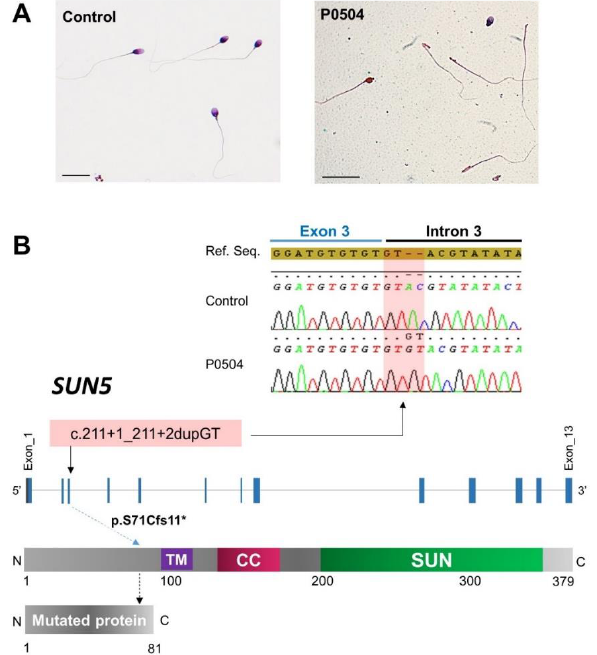
Figure 1. Sperm morphology and a description of the identified SUN5 variant. ( A ) Light microscopy analysis of spermatozoa from a fertile control individual and a subject carrying the identified SUN5 variant (P0504). Mutated subjects have numerous isolated flagella and few isolated abnormal heads. Scale bars = 20 µ m. ( B ) The identified homozygous variant, as shown in the electropherograms, is located within a GT repetitive sequence located at the junction of exon 3 and the downstream intron (intron 3). We observe that the end of the exon 3 sequence contains three repetitive GT doublets, followed by the consensus donor splice-site sequence (GT) in intron 3. The identified variant causes the extension of this repetitive sequence and is predicted to impact both splicing and translation, leading to the production of a short and non-functional SUN5 protein. The purple box represents a transmembrane domain (106–122 aa). The pink box represents a coiled-coil domain (155–183 aa), and the green box represents the Sad1/UNC-like C-terminal domain (205–364 aa) according to the Ensembl database (protein domains for ENSP00000348496.3). The red box represents the predicted protein in